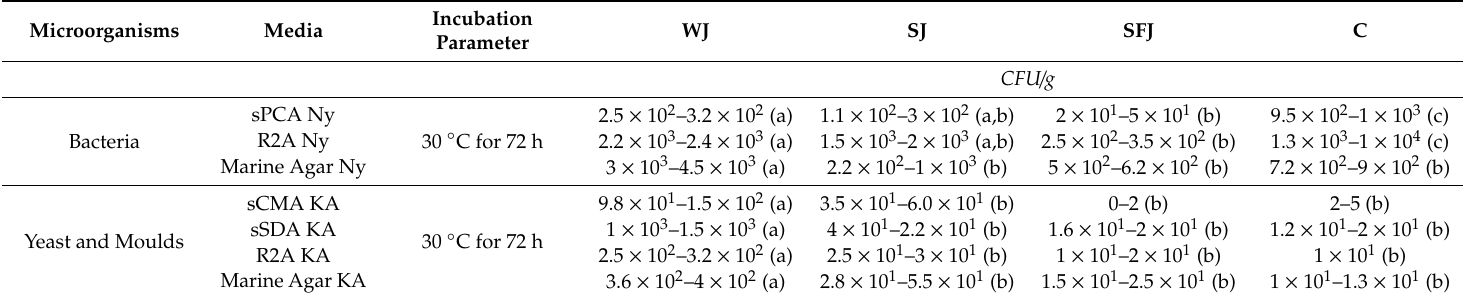
Table 3. Bacteria, Yeast and Molds total counts obtained by JF and seawater samples using di ff erent saline media. Average of data obtained in four sampling periods (June, July, August and October 2018). a,b,c—the di ff erent letters in line indicate significant di ff erences among JF samples and seawater samples in the same assay ( p <